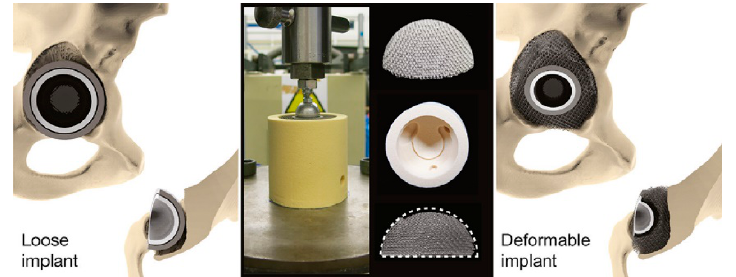
Figure 17. The meta-implant design has the potential to deform and fill up defects, restoring the physiological loading condition. The implants were compressed in bone-mimicking molds to evaluate their deformability [221].